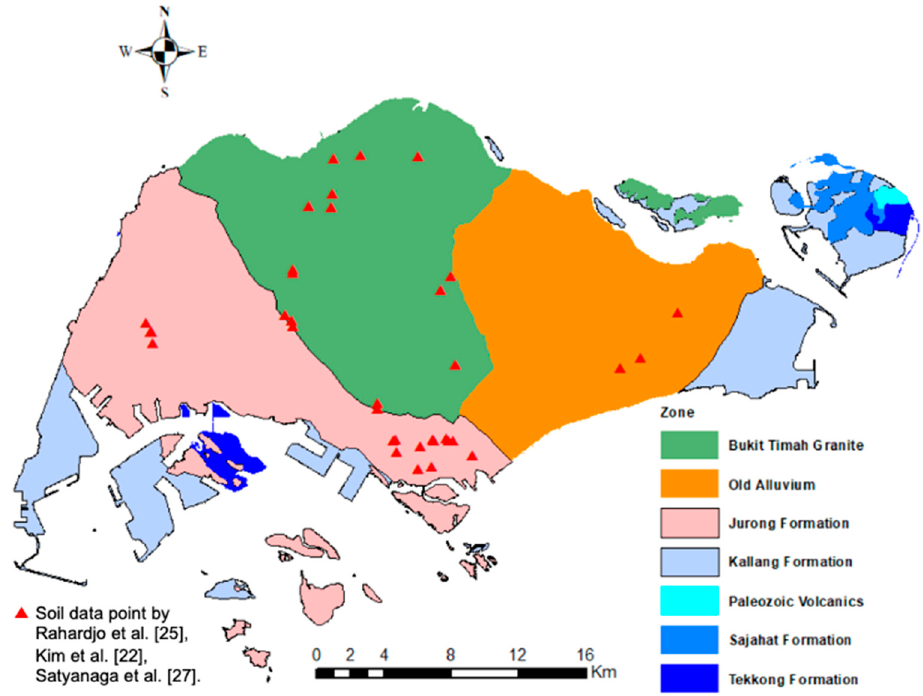
Figure 1. Distribution of Singapore geological formations and soil database points studied by researchers [22,25,27] (modified from Kim et al. [22]).